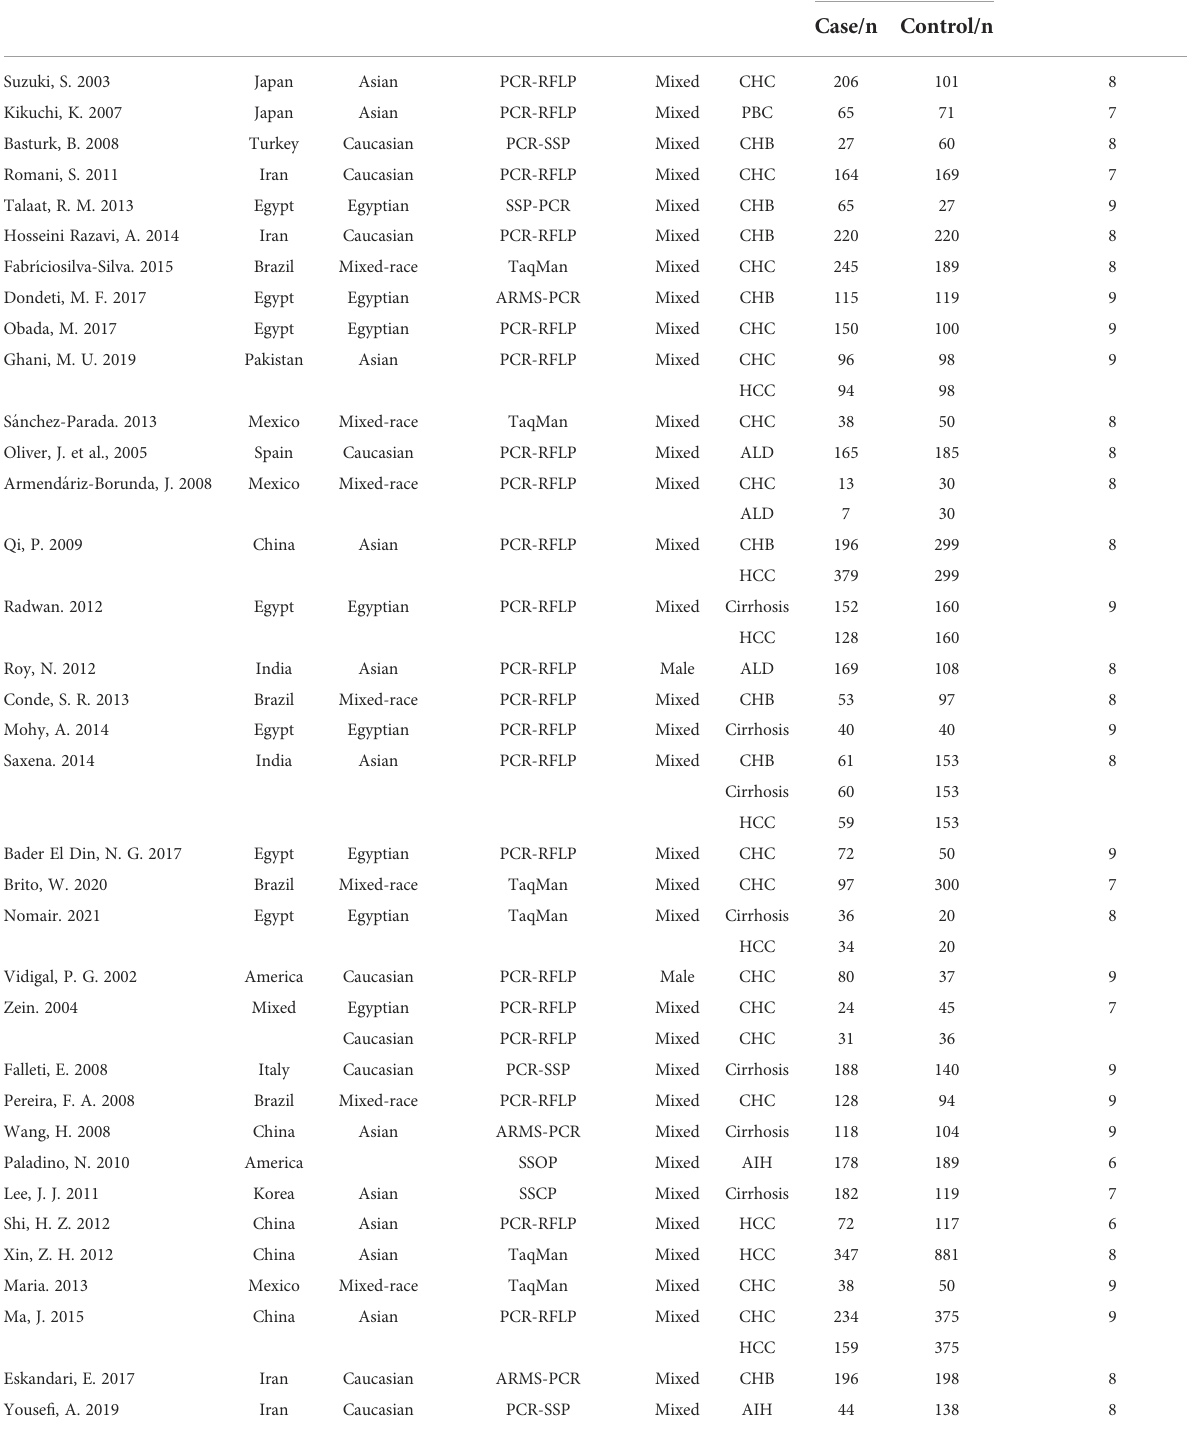
TABLE 1 The characteristics of included studies.